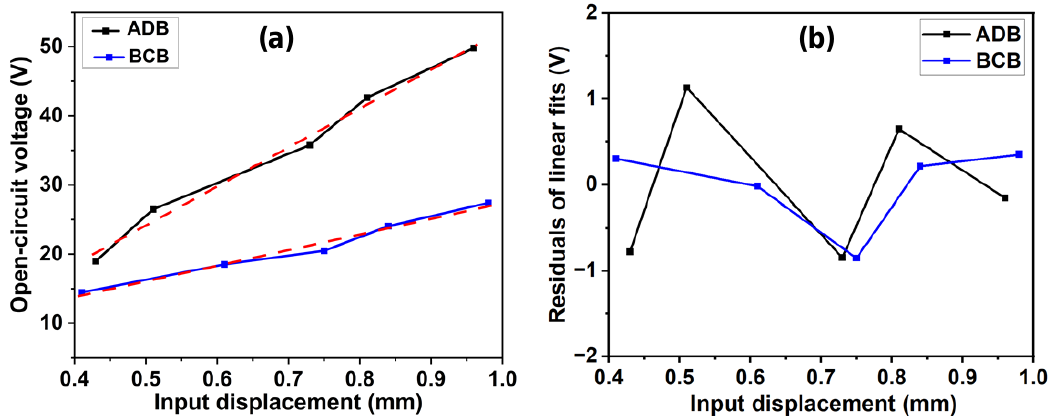
Figure 6. ( a ) the measured open-circuit voltage of ADB and BCB and ( b ) the residuals of linear fits.